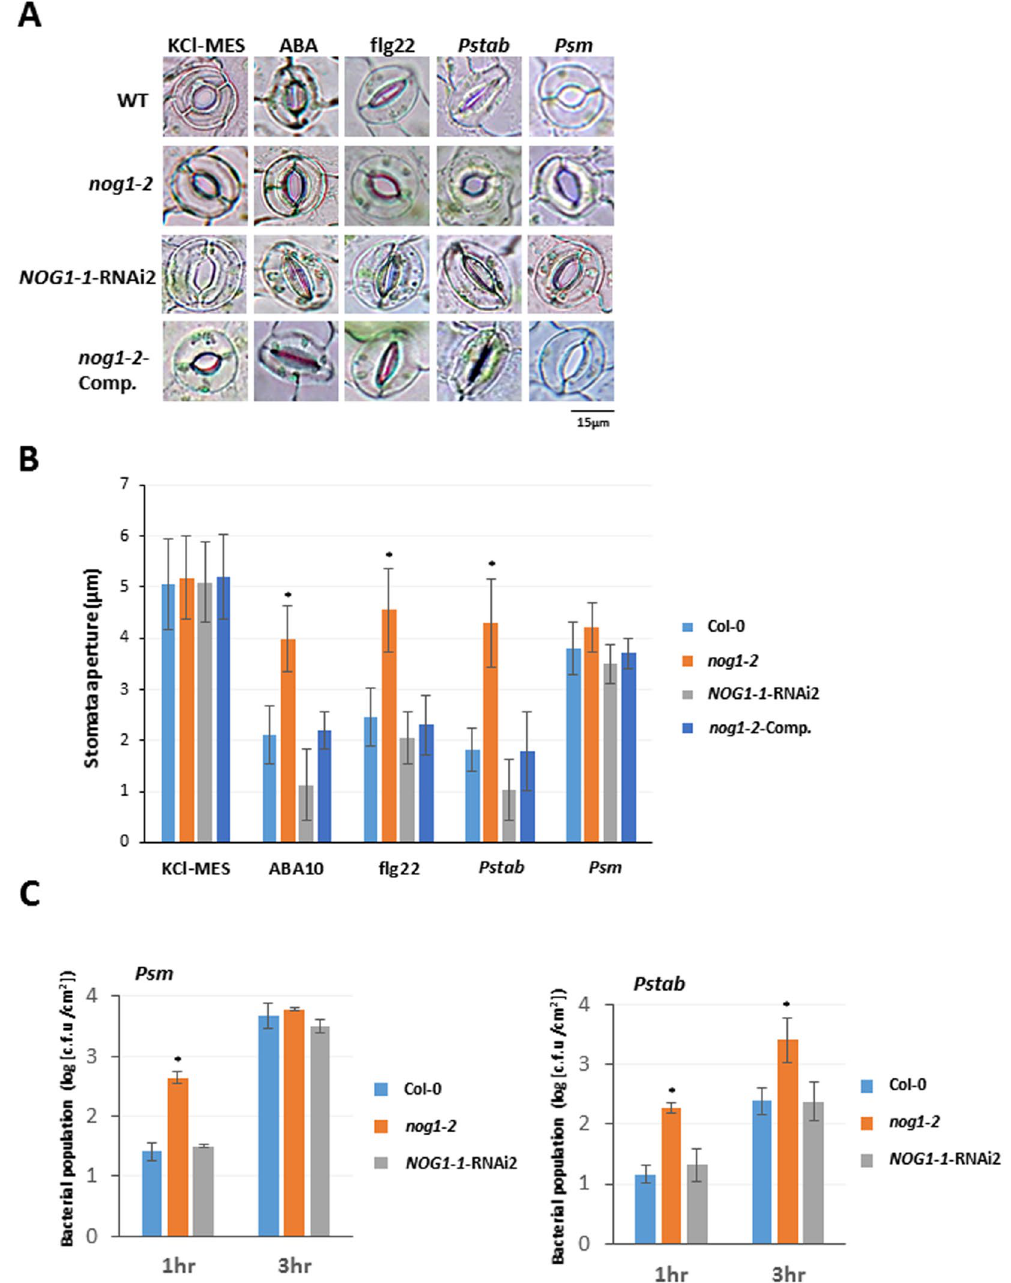
Figure 5. ABA, PAMPs, and nonhost bacterial pathogens induce stomatal closure in NOG1-2 -dependent manner. ( A , B ) The nog1-2 line impairs ABA-, PAMPs- and nonhost-bacterial-pathogen-induced stomatal closure. To observe stomatal behavior, epidermal peels of Col-0, nog1-2 , NOG1-1-RNAi2 , and NOG1-2 complemented lines were treated with stomata-opening buffer (KCl-MES), ABA (10 µ M or 50 µ M), flg22 (20 µ M), Pstab and Psm at 1 × 10 4 CFU/ml. Microscopic images were taken 3 hr after inoculation. The aperture size of stomata was measured after 30 min for ABA, 1 hr for flg22 and LPS, and 3 hr for Pstab and Psm . Asterisks indicate significant difference by Student’s t -test ( P < 0.05). Error bars indicate standard error for counting 50 stomata/each epidermal peel. Three samples were examined for each treatment, and the experiment was repeated at least three times with similar results. ( C ) Bacterial entry through stomata in nog1-2 and NOG1-1- RNAi2 lines. To quantify bacterial entry, detached Arabidopsis leaves from wild-type Col-0 and nog1-2 and NOG1-1-RNAi2 were floated in bacterial suspensions (1 × 10 4 CFU/ml) of the nonhost pathogen ( Pstab ) or host pathogen ( Psm ). After 1 hpi and 3 hpi, leaves were surface-sterilized with 10% bleach, ground, serially diluted and plated on KB media ( B ). After 2 days, the number of bacterial colony was counted. This experiment was repeated three times and showed similar results: five replications in each experiment. Asterisks indicate significant difference by Student’s t -test ( P <